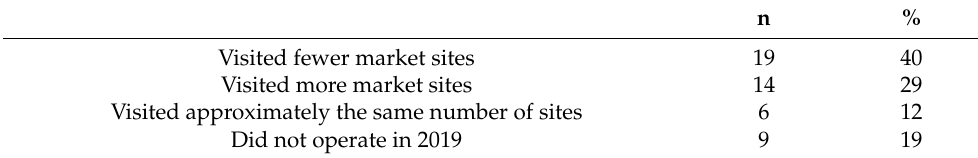
Table 4. Changes in Number of Sites Visited in 2020 Compared to